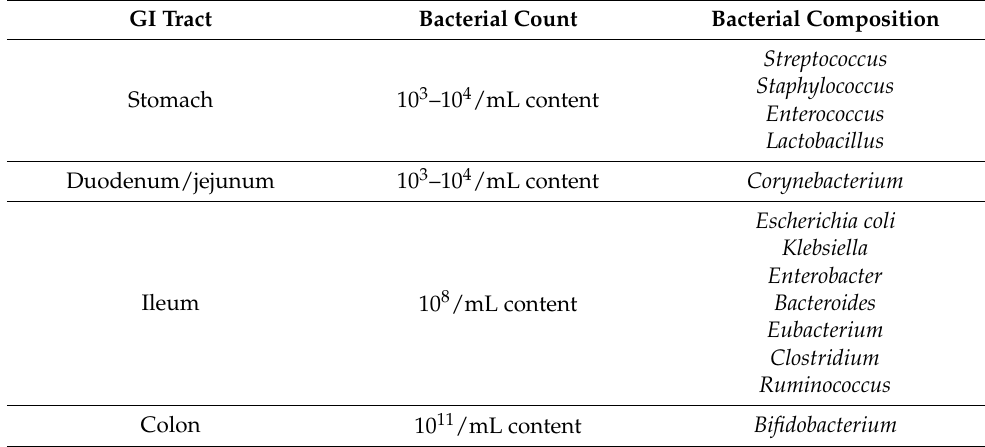
Table 1. GI tract bacterial count and composition in humans. Data from [6]. GI Tract Bacterial